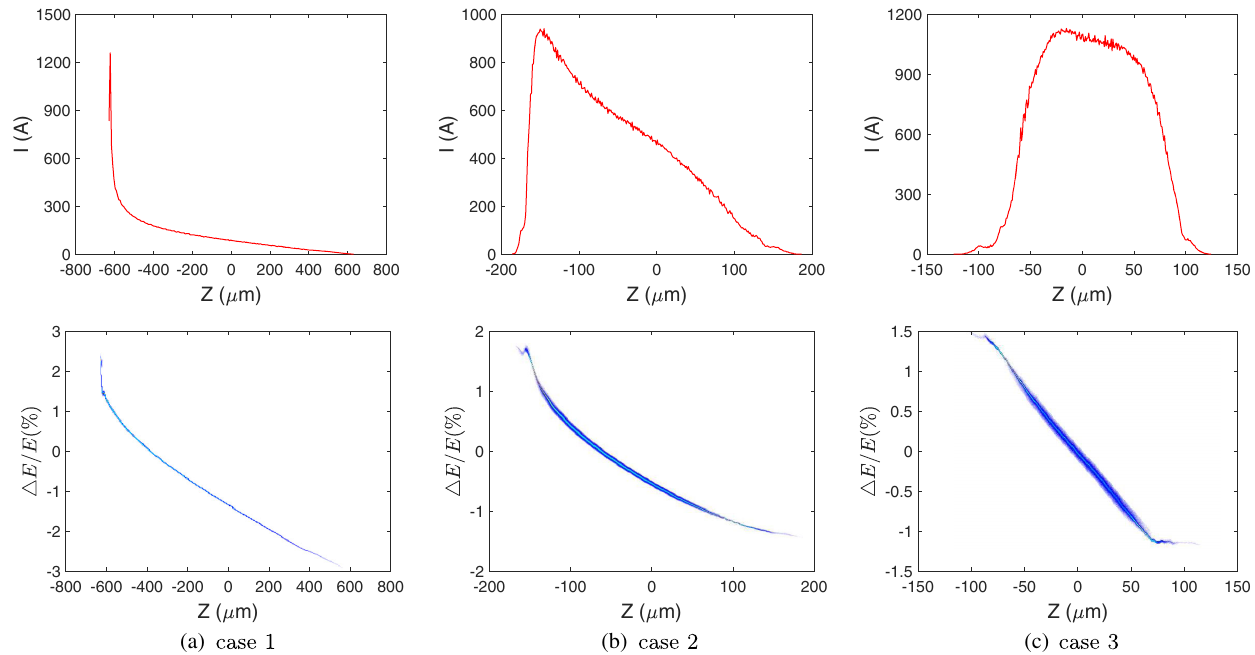
FIG. 5. Current profile (upper) and longitudinal phase space (lower) of the three typical electron bunches selected from the Pareto- optimal